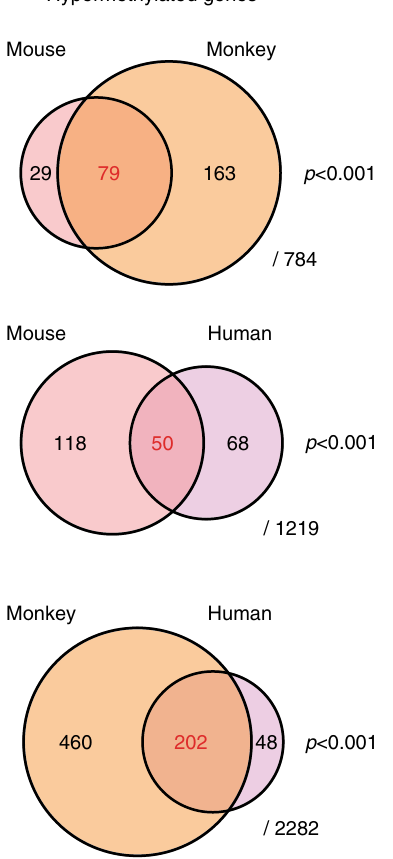
Fig. 2 Methylation analysis by DREAM in mouse, monkey, and human DNA. Area-proportional Venn diagrams of overlapping gene promoters ( − 1kb < TSS < + 500 bp) showing age-related methylation drift in whole blood in each combination. The denominators represent the number of homologous genes with high-quality sequence data (sequencing depth ≥ 100 reads in 75% of cases), which are detectable between two species in each comparison. We counted the number of genes using human homolog gene names of mouse and monkey genes in each comparison. A χ 2 -test using 2×2 tables (Supplementary Table 12) was used to calculate p -values for the signi fi cance of the overlaps. p -values are indicated on the right